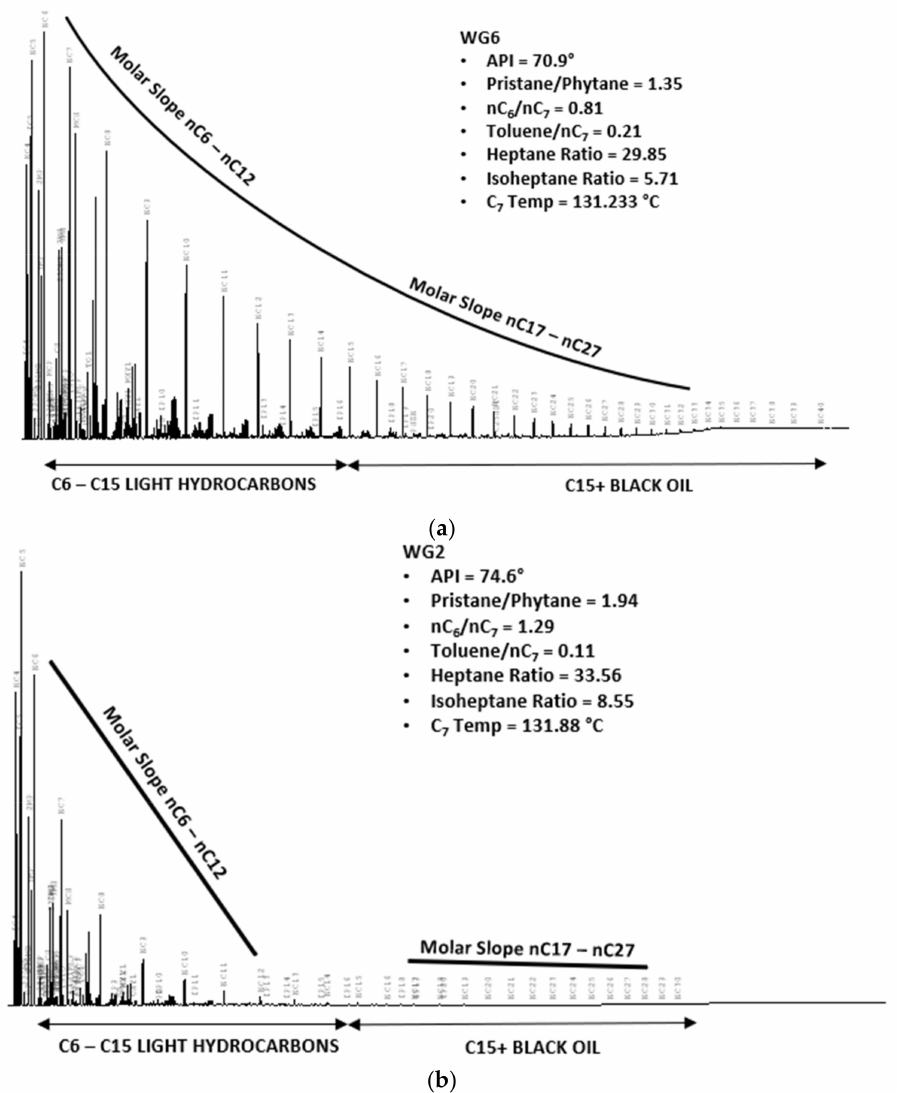
Figure 13. High resolution gas chromatograms of two produced condensates collected in the wet gas-producing region. The solid black lines illustrate the molar slope(s) [53] of n-alkane peak heights for light (nC 6 –nC 12 ) and C 15+ hydrocarbons. These two chromatograms represent end member compositional extremes observed in Marcellus condensates in the basin. ( a ): The WG6 condensate exhibits a unimodal n-alkane distribution with a maxima at nC 6 , resolvable hydrocarbons out to nC 40 , and a smooth transition of molar slope between light hydrocarbons and black oil. ( b ): The WG2 fluid shows has a maxima at nC 5 , but GC peak responses are much diminished beyond nC 12 and there is a distinct break in the molar slopes of the light hydrocarbons and black